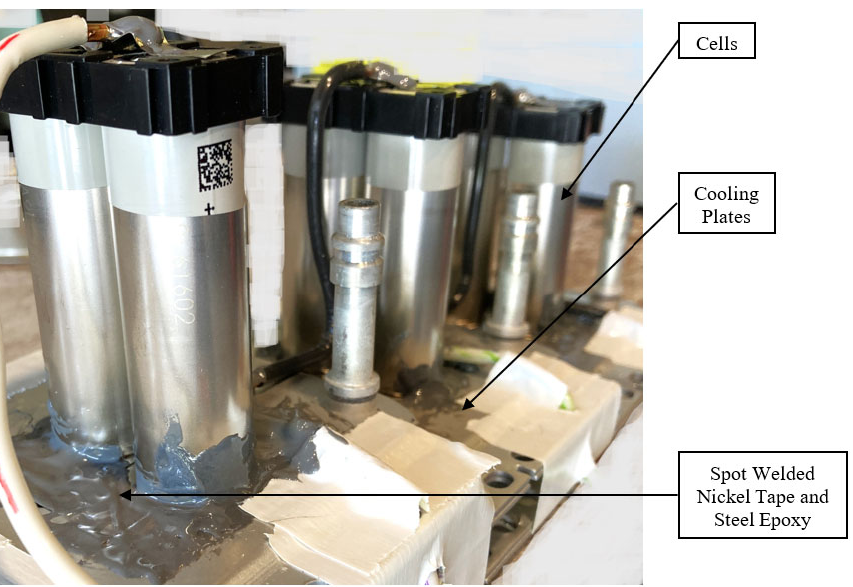
Figure 2. Close-up image of the cells (21 mm diameter × 70 mm height) and assembly including spot welds and reinforced steel epoxy.